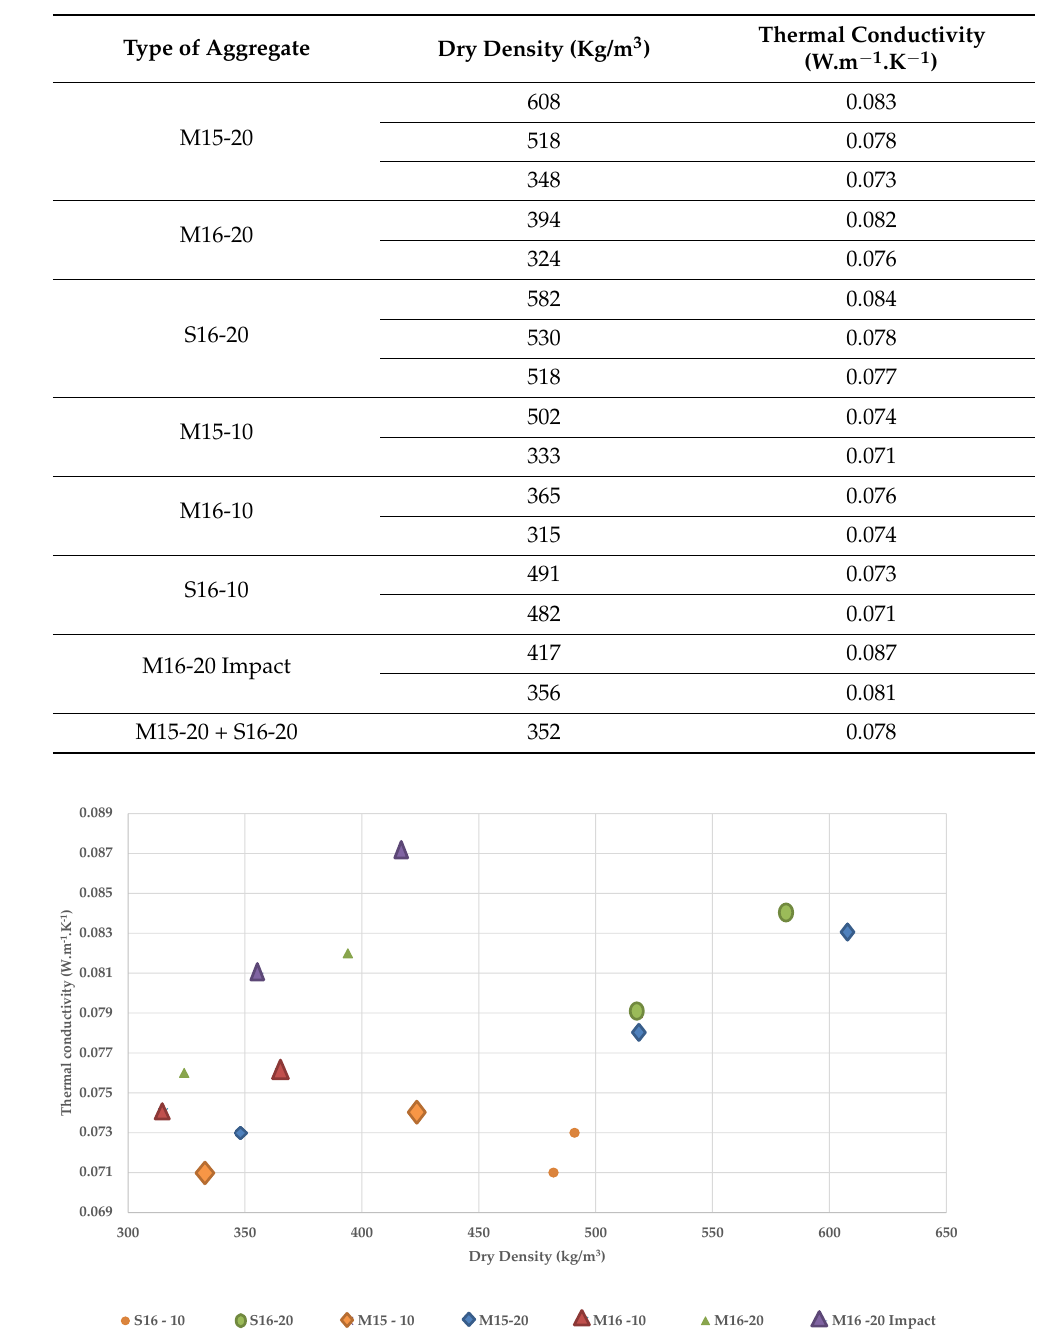
Table 7. Thermal conductivity variation according to the density and type of rapeseed concrete.